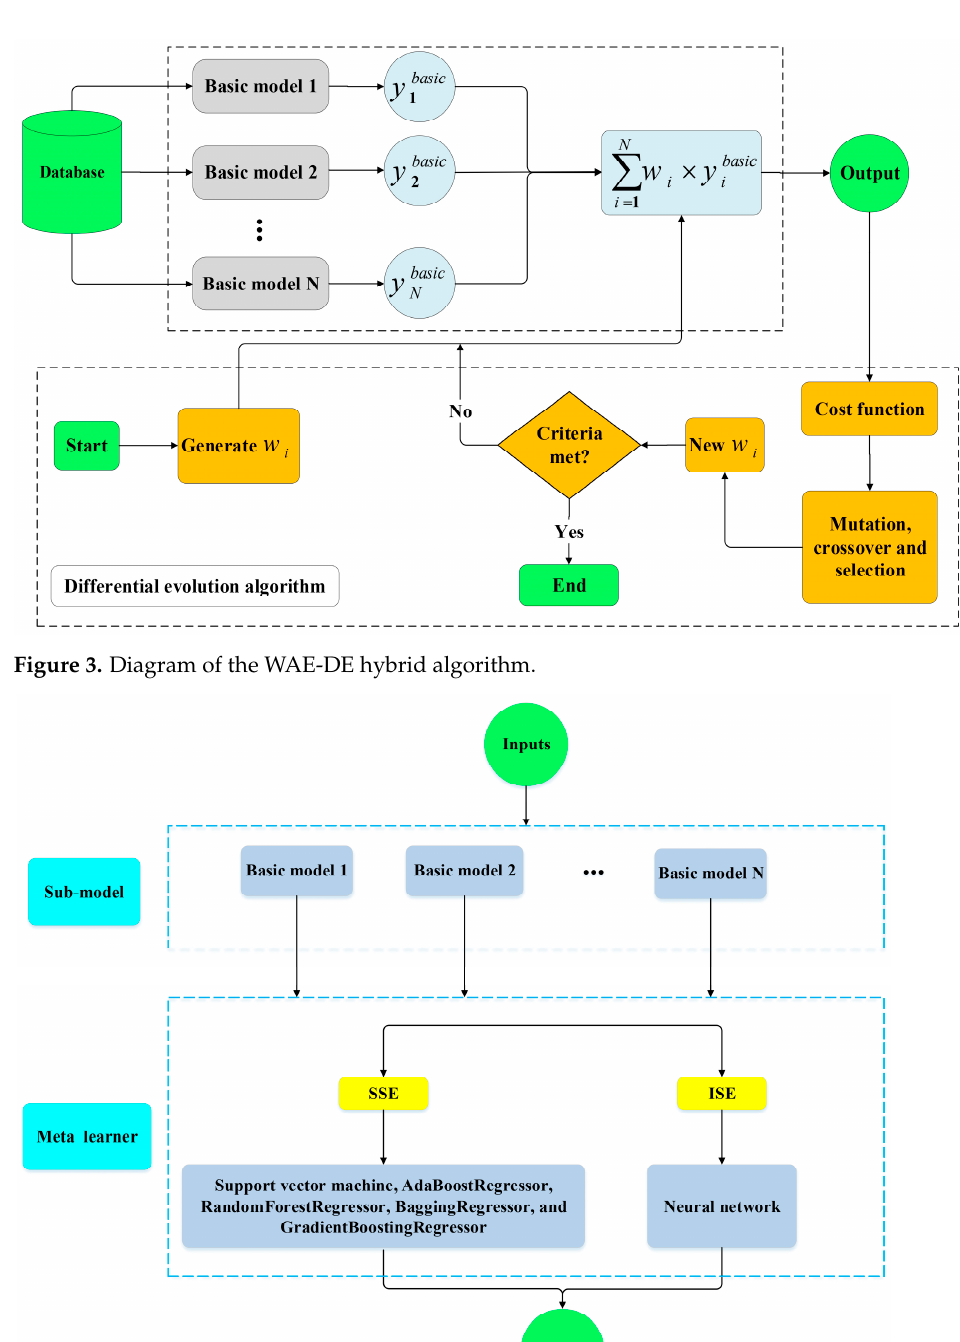
Figure 4. Workflow of the stacking ensemble method.